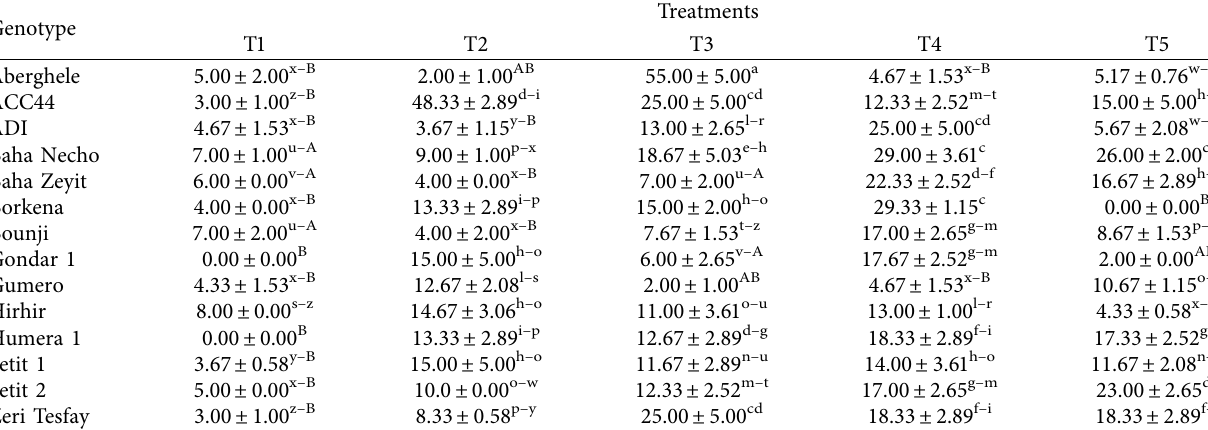
Table 5: Interaction effects of IBA and NAA supplements and genotypes on the mean root